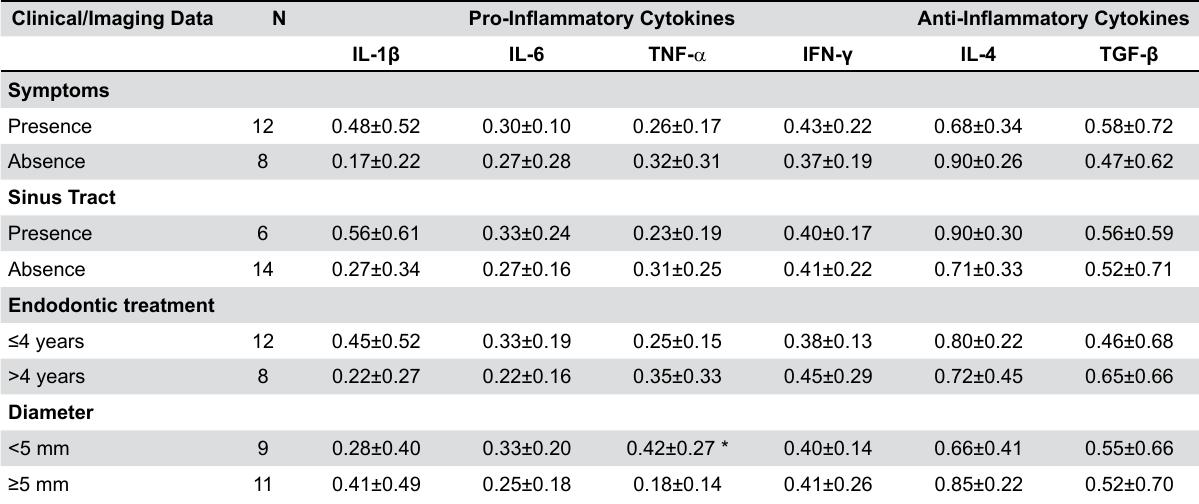
Table 3- Comparison between pro-inflammatory and anti-inflammatory cytokine expression and clinical and imaging data in periapical